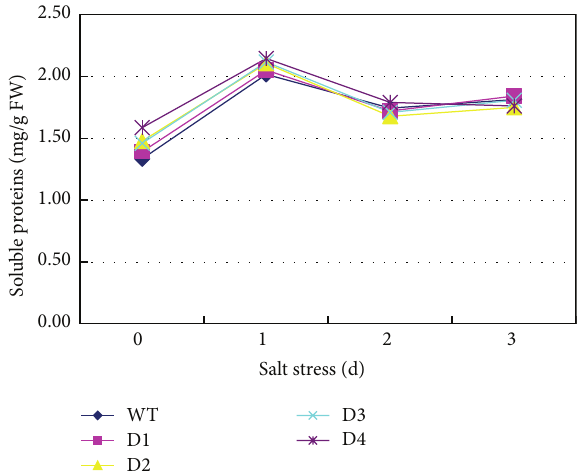
Figure 4: Soluble protein content in the WT plants and SbPIP1 gene transgenic lines. D1, D2, D3, and D4 represent the transgenic lines D1, D2, D3, and D4, respectively; WT represents the untransformed wheat variety Ningmai 13.